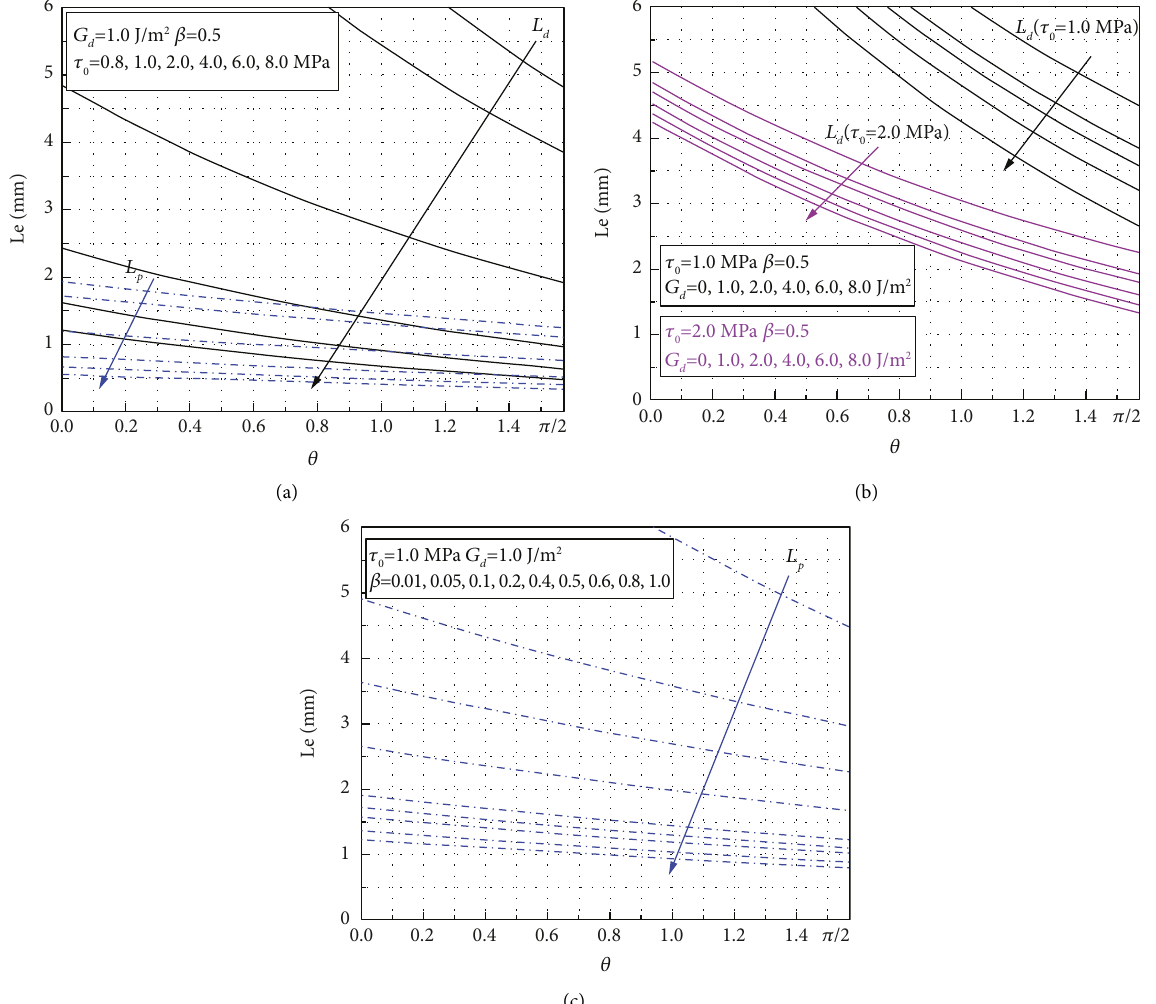
Figure 10: Interfacial parameter impact analysis to fiber rupture: (a) the effect of τ